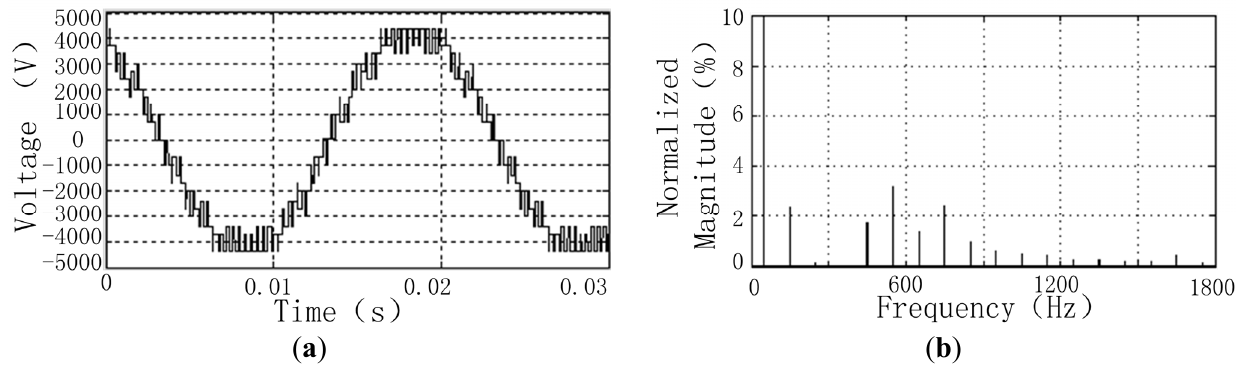
Figure 6. Result of the conventional PSCPWM when the second cell dc voltage is 690 V: ( a ) output voltage waveform; and ( b ) harmonics.